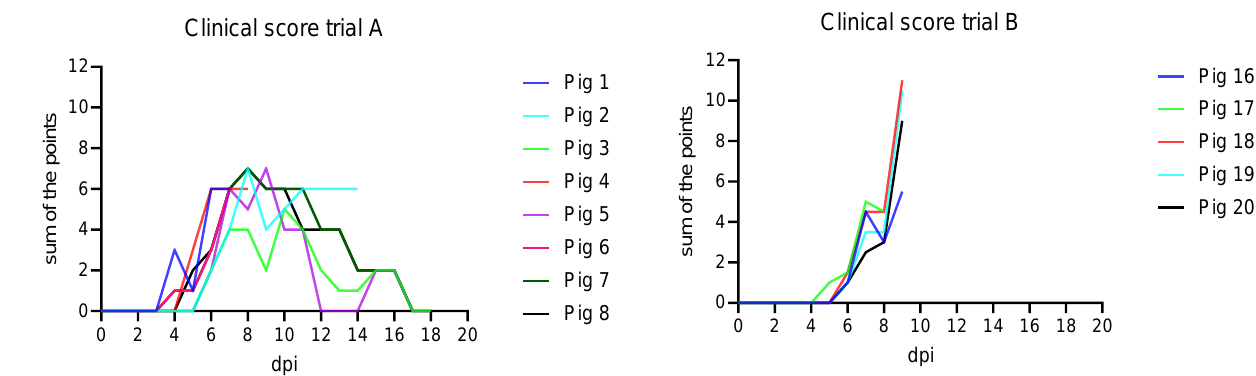
Figure 1. Clinical curve of trials A and B compared. In trial A, the maximum score of the animals was a sum of 7 points at 8 and 9 dpi compared to trial B, where animals reached scores of up to 11 points at 9 dpi.